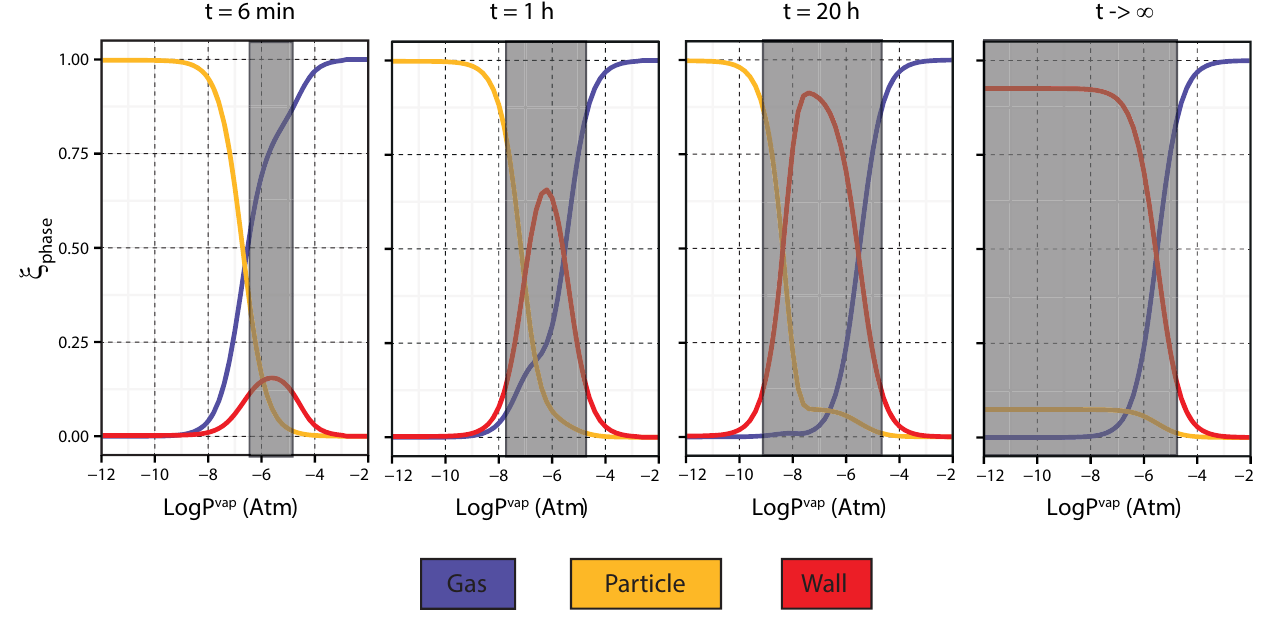
Figure 2. Time evolution of the fraction in the gas, particle and wall phases as a function of the vapor pressure for a continuous distribution of species considered to be initially only in the gas phase. Grey zones represent the volatility range impacted by wall losses at a molar fraction higher than